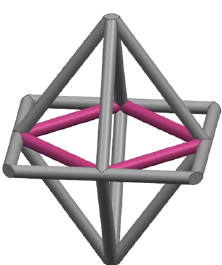
Figure 3. Partitioning of Structure 9.